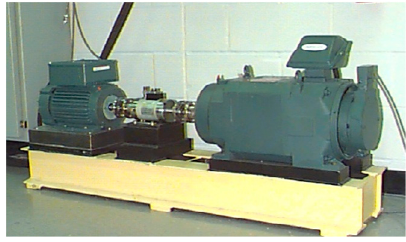
Figure 8. The experimental station of rolling bearing.